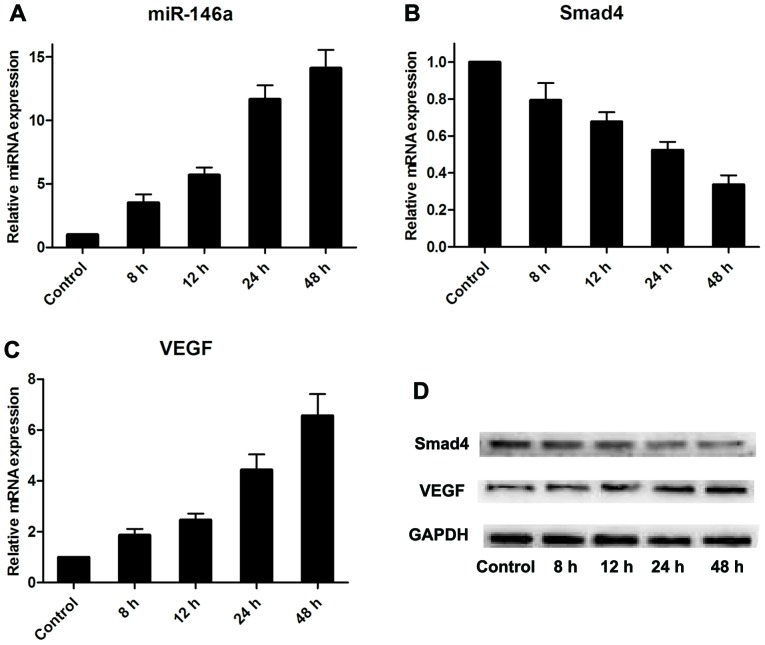
Mechanical pressure injury rapidly induced miR-146a and vascular endothelial growth factor (VEGF) expression and downregulated Smad4 expression in a time-dependent manner after the injury was sustained. Human chondrocytes were loaded with mechanical pressure (10 Mpa, 60 min). Expression levels of miR-146a, Smad4 and VEGF were monitored by RT-qPCR and western blot analysis at the indicated times after the injury was sustained. (A) miR-146a expression was significantly increased over a 48-h time course (P<0.05, n=3). (B) mRNA levels of Smad4 were reduced after mechanical pressure injury (P<0.05, n=3). (C) VEGF expression was upregulated by mechanical pressure injury (P<0.05, n=3). (D) Protein levels of Smad4 and VEGF were, respectively, decreased and increased in chondrocytes in a time-dependent manner after mechanical pressure injury. GAPDH was used as an internal control. Control, non-loaded cells.